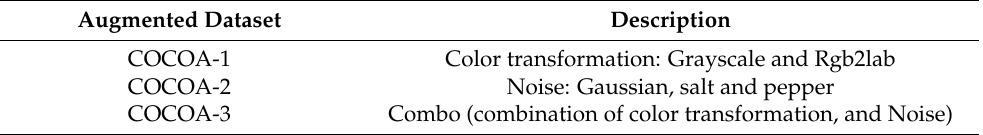
Table 2. Summary of Augmented dataset and reference names of image augmentations used.